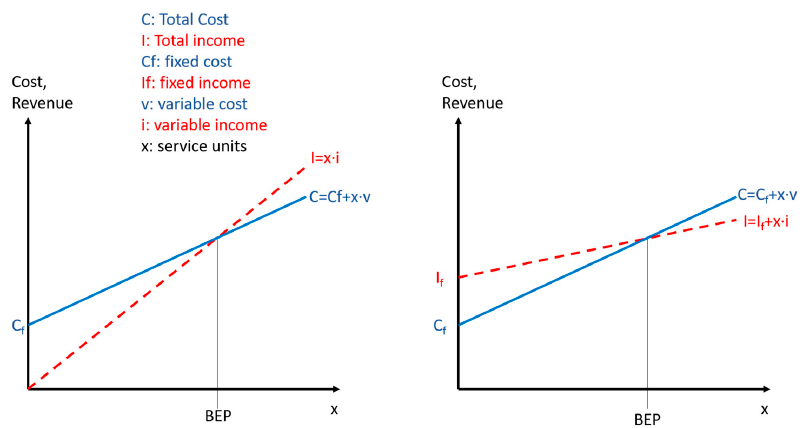
Figure 2. Traditional and flipped break-even. Source: own, based on [39].